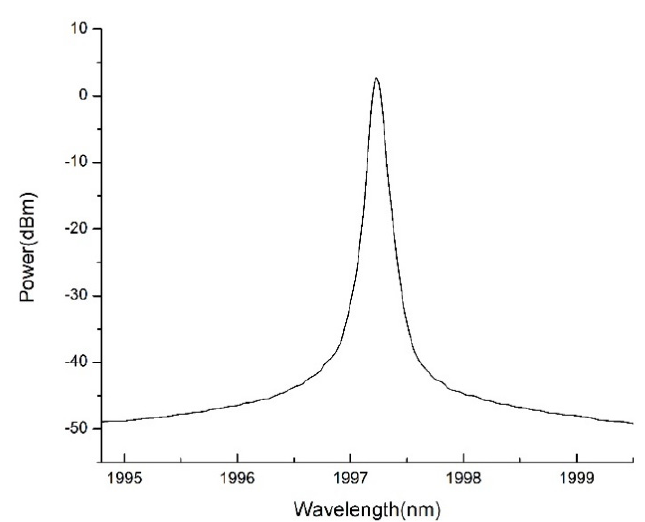
Figure 5. Typical output from thulium-doped fiber laser based on a DMD chip.